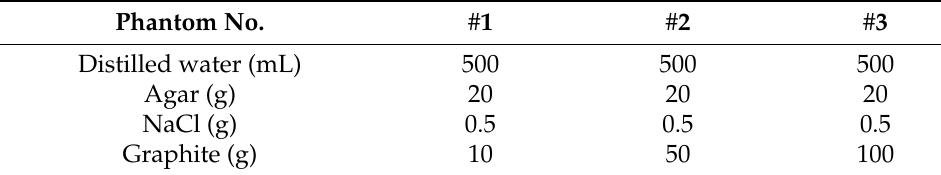
Table 1. The mixture composition of graphite-agar phantoms. Phantom